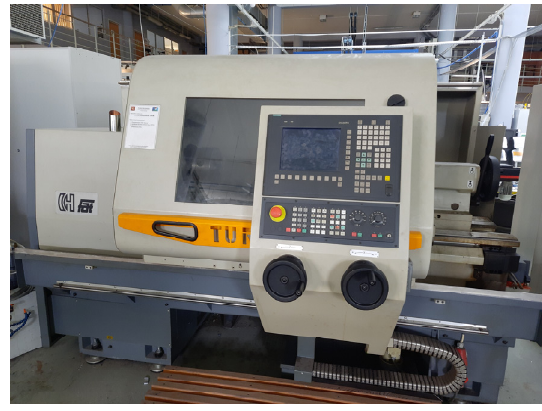
Figure 2. NC lathe used in tests.